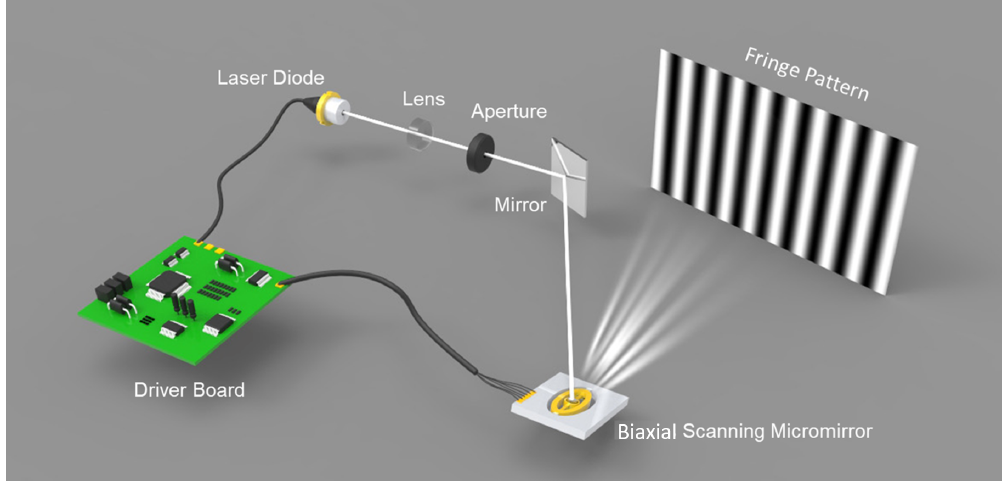
Figure 2. Schematic diagram of the biaxial Microelectromechanical Systems (MEMS)-based fringe pattern projection